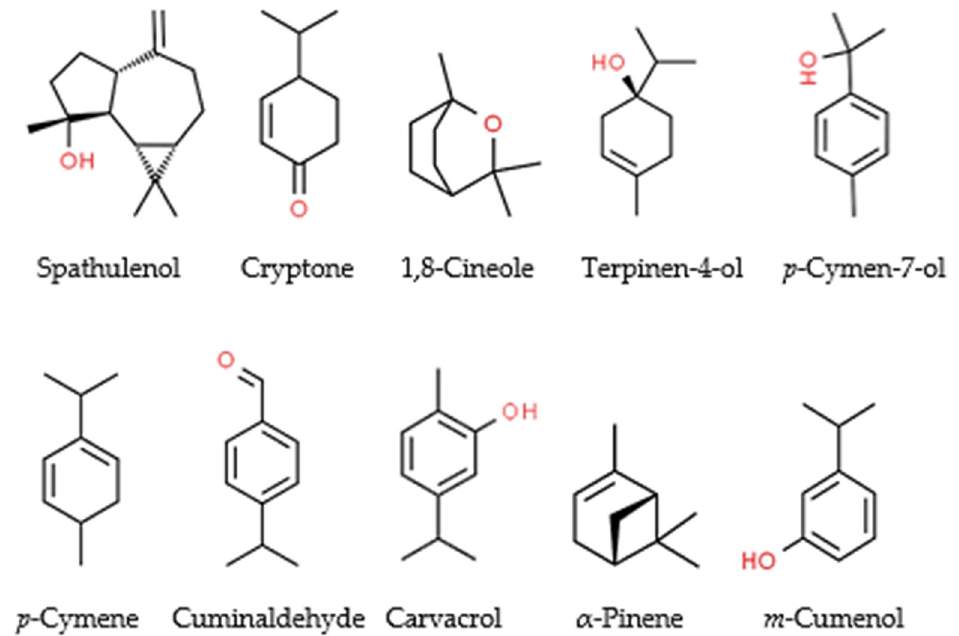
Figure 1. Chemical structure of main terpenes and terpenoids (highlighted with red O or OH) identified in the essential oil of Eucalyptus largiflorens . Table 1. Chemical profile of the essential oil extracted from Eucalyptus largiflorens leaves.